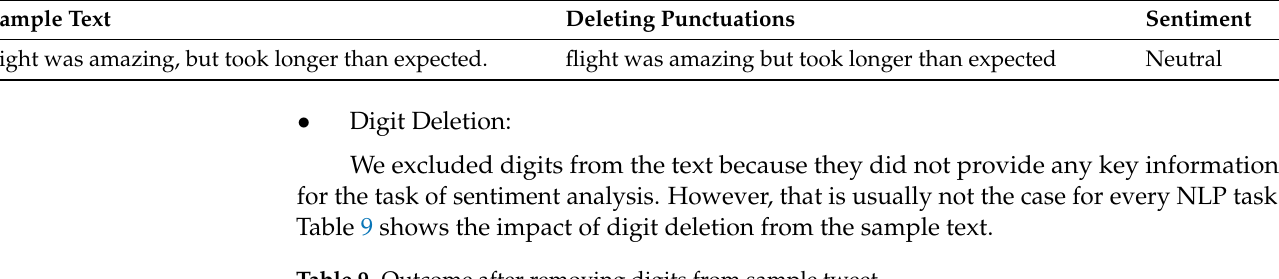
Table 9. Outcome after removing digits from sample